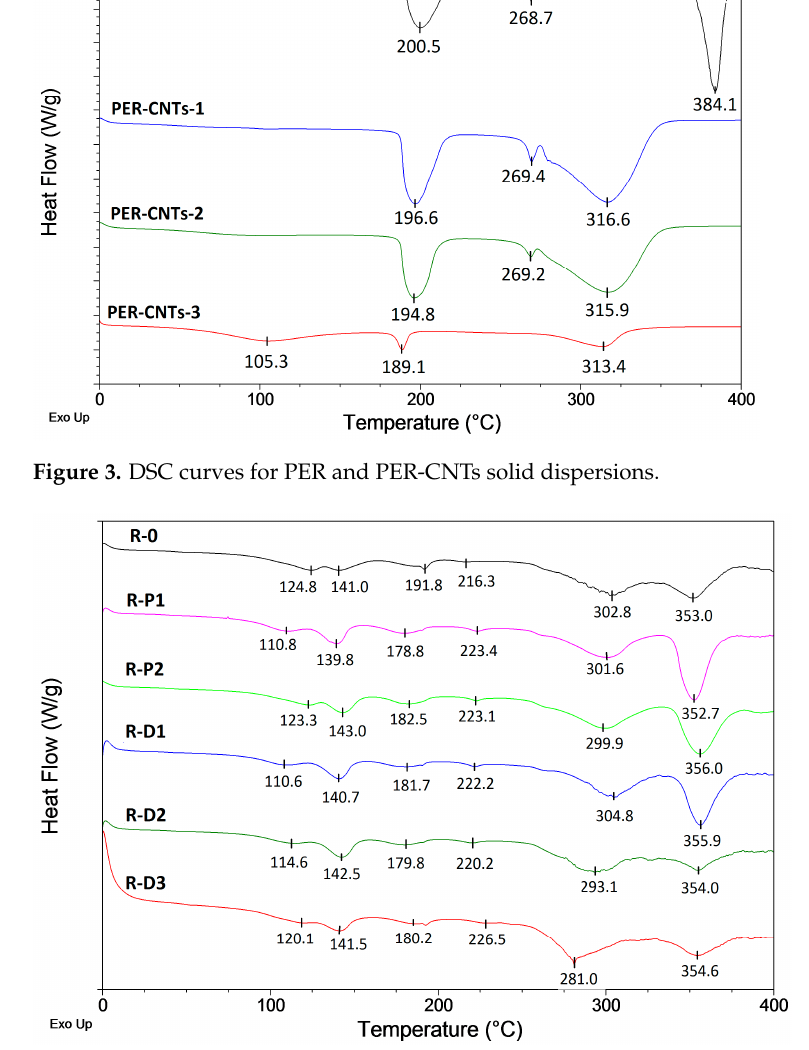
Figure 4. DSC curves for intumescent coatings with CNTs or PER-CNTs solid dispersions.